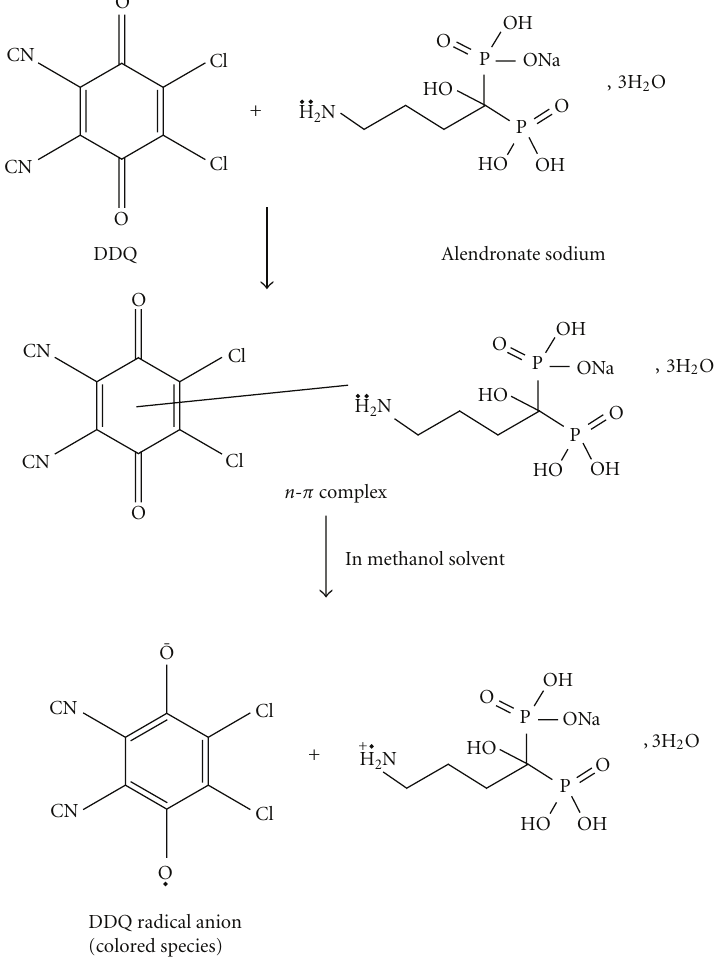
Scheme 1: Reaction involved in analysis of alendronate sodium.